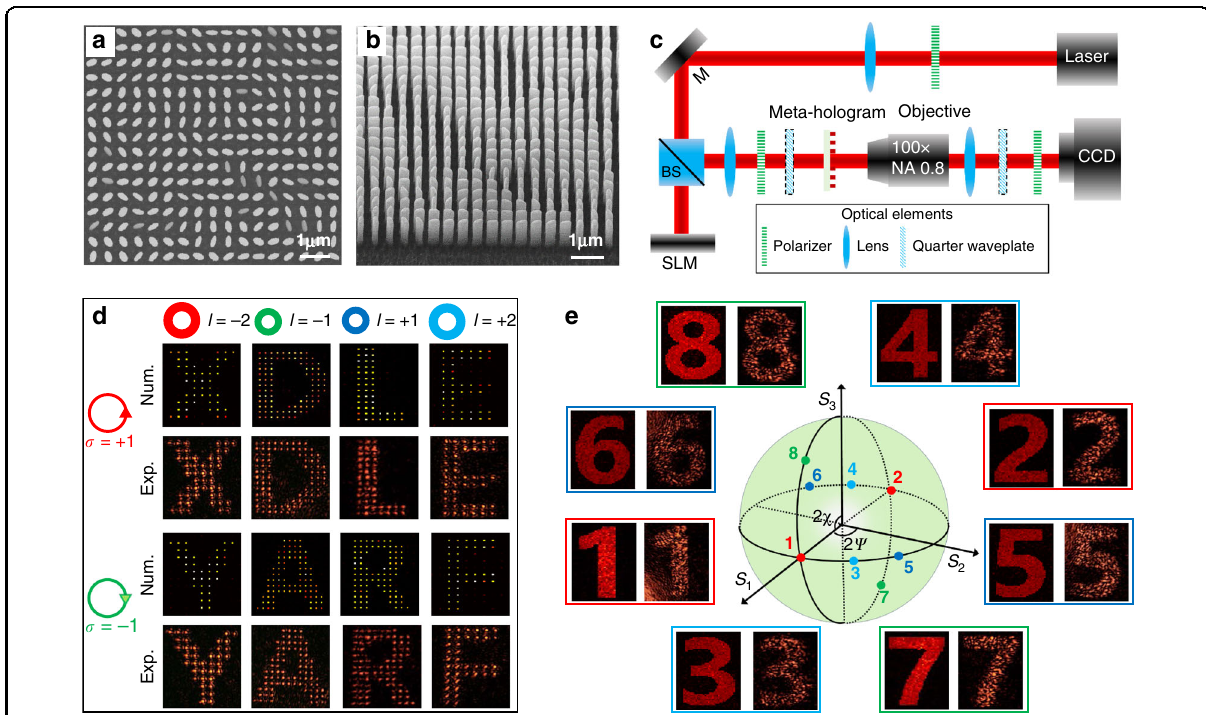
Fig. 3 Experimental characterization of an AM meta-hologram with 16-bit independent holographic images. a , b Top and side views SEM images of the fabricated meta-hologram, with the scale bar to be 1 μ m. c Characterizing system for the measurement of fabricated meta-hologram, where a spatial light modulator (SLM) along with a quarter waveplate (QWP) are used to generate required CP vortex beams. BS: beam splitter, SLM: spatial light modulator, M: mirror, CCD: charge-coupled device. The dashed boxes indicate that the QWP is removable in the certain measuring process. d Numerical and experimental reconstruction of the eight distinctive SOL holographic images through incident CP vortex beams with speci fi c | σ , l > . e Numerical and experimental reconstruction of the eight distinctive SS holographic images through a XLP incident light and extracting certain SoPs via utilizing speci fi c analyzers. The corresponding SoPs of the eight holographic images indicate by eight points on the